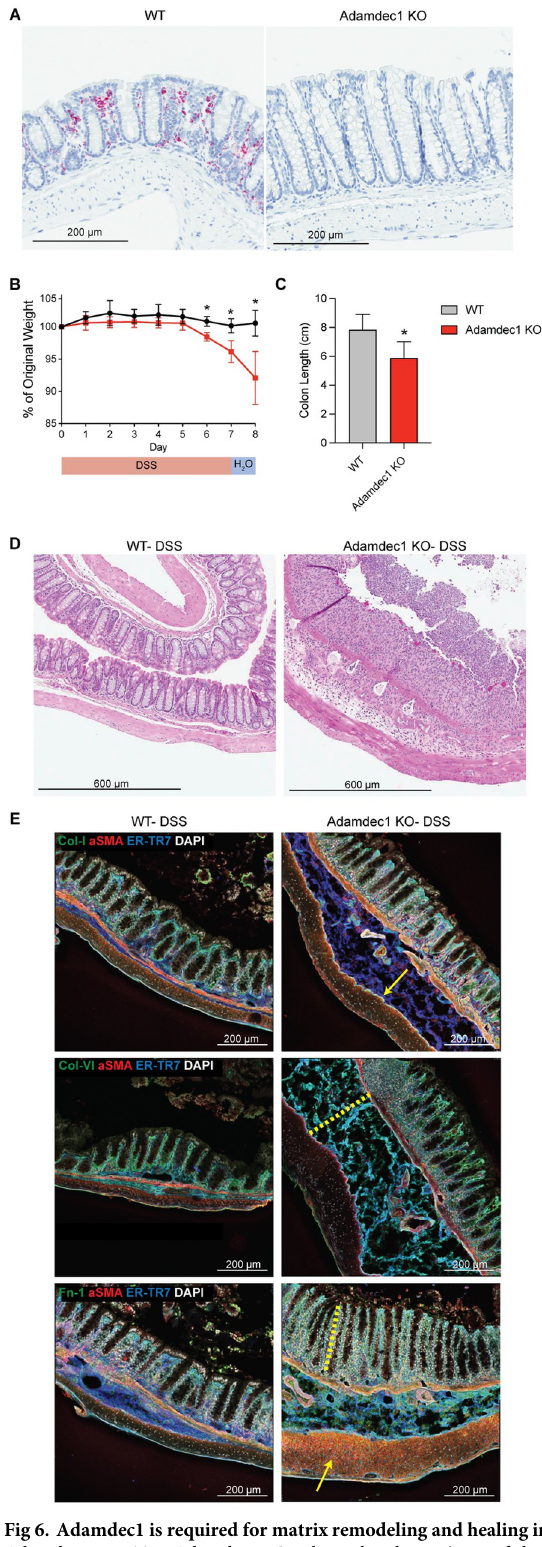
Fig 6. Adamdec1 is required for matrix remodeling and healing in response to epithelial injury. (A) ISH of Adamdec1 in WT or Adamdec1 KO colon at basal state (water-fed mice). Scale bar, 200 μ m. n = 2 per cohort.